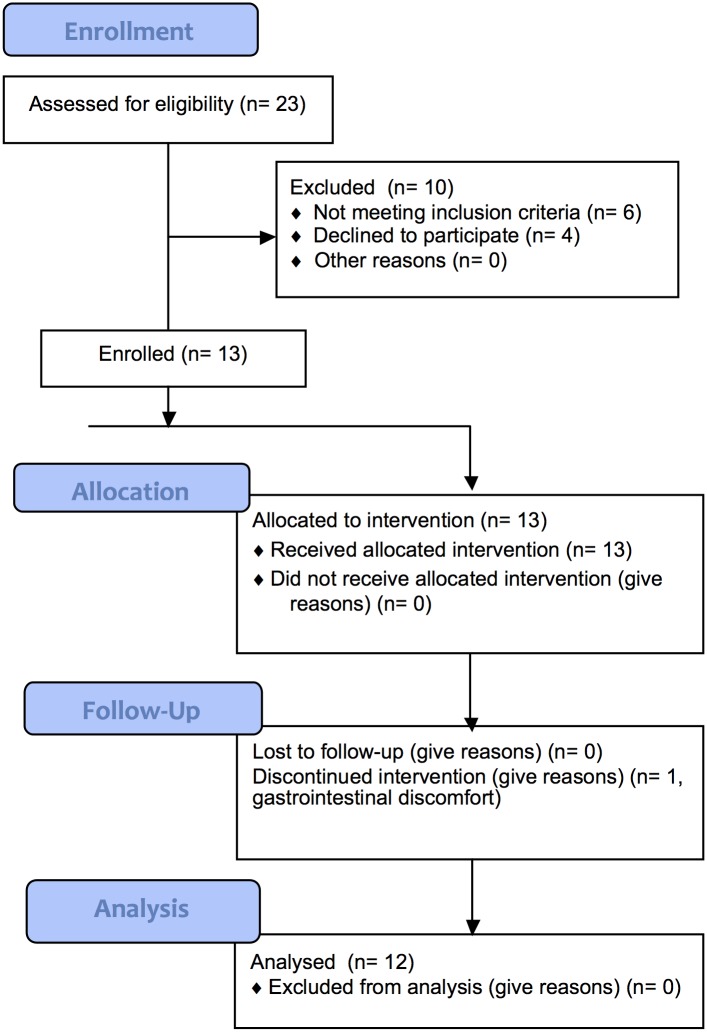
Consort Diagram.